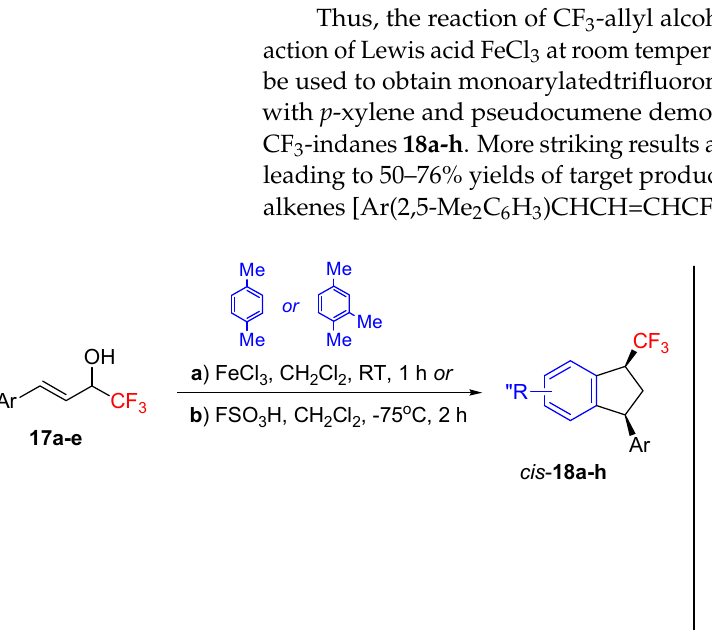
Scheme 11. Generation of species D and E ( E ′ ↔ E ″ ) from CF 3 -allyl alcohols 16 under the action of Brønsted or Lewis acids.